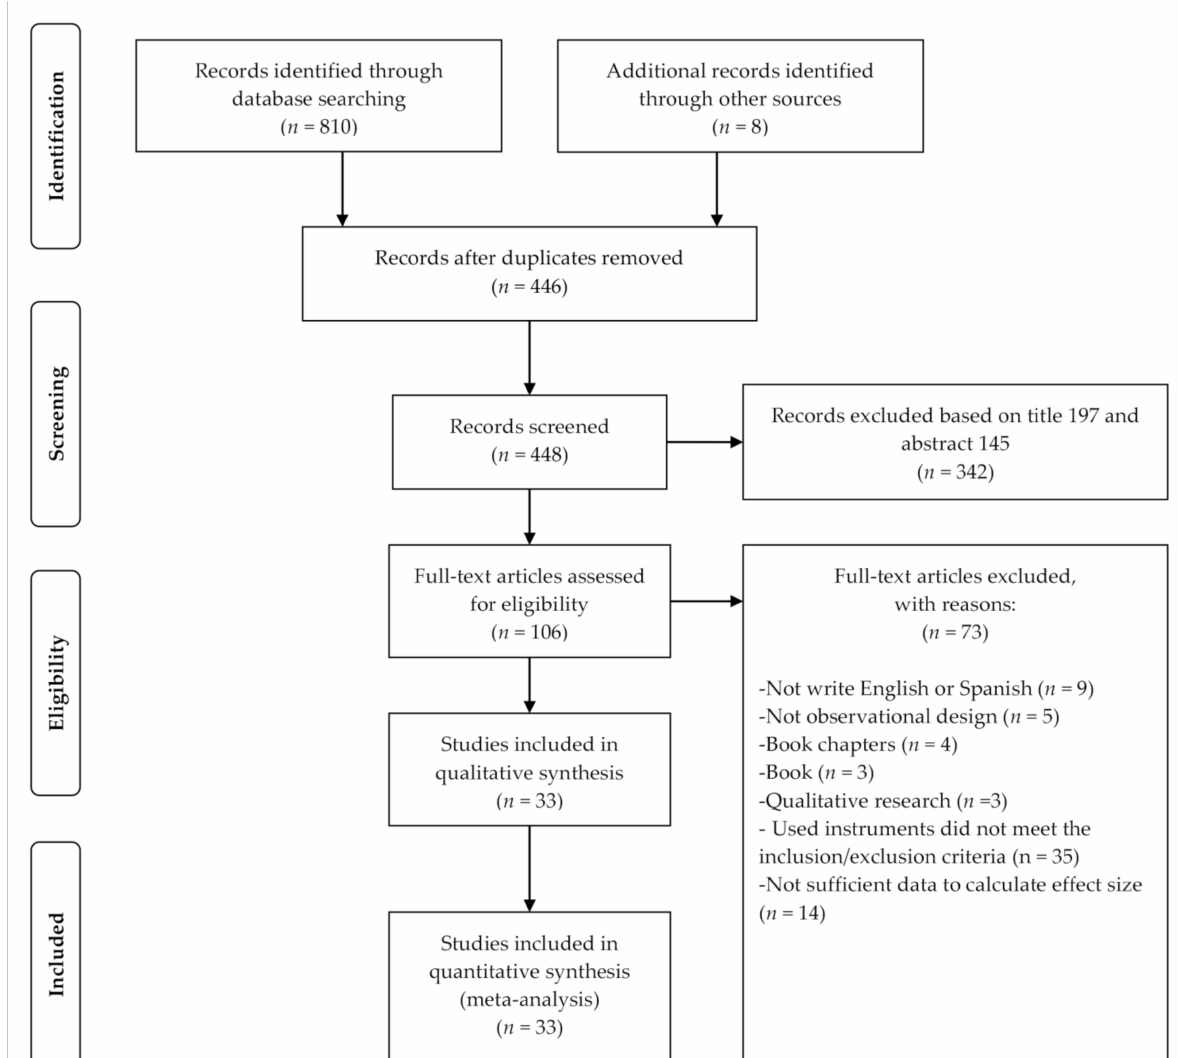
Figure 1. PRIMA flow diagram of study